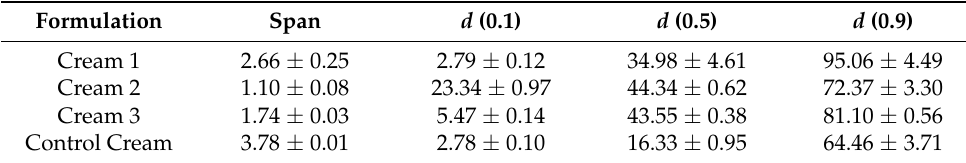
Table 7. Droplet size distribution. Results are mean ± SD, n = 3. Formulation